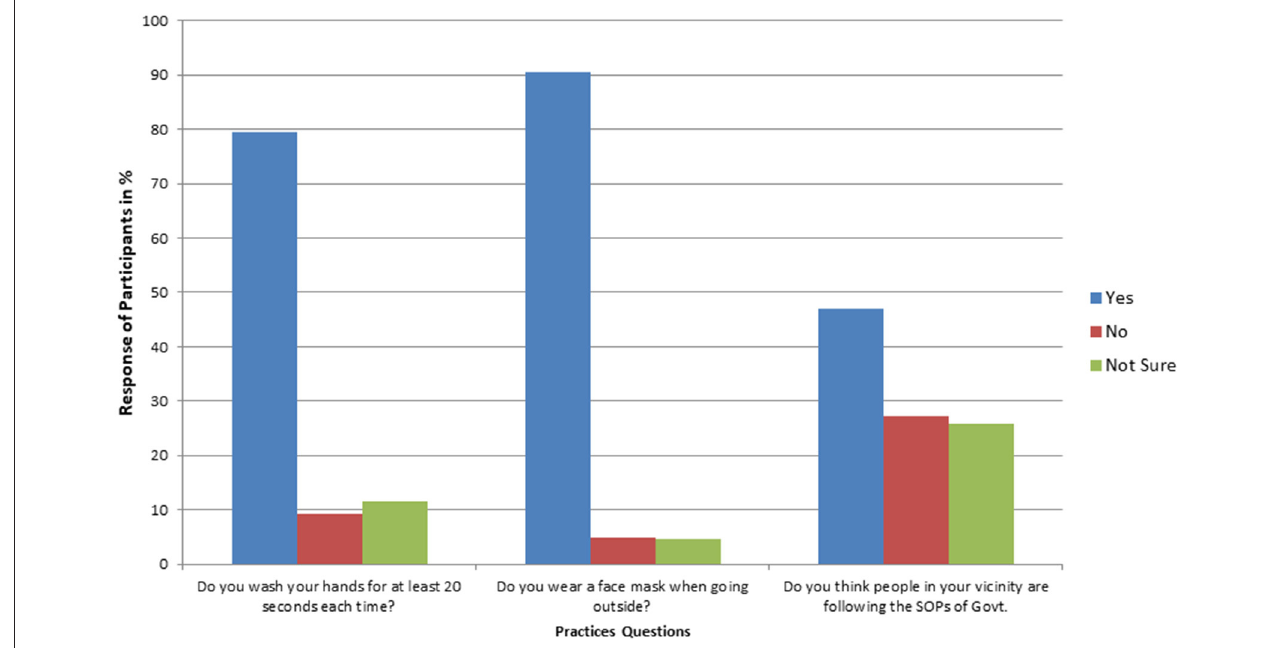
FIGURE 3 | Percentage response of participants on important questions regarding the practices for COVID-19 ( N =